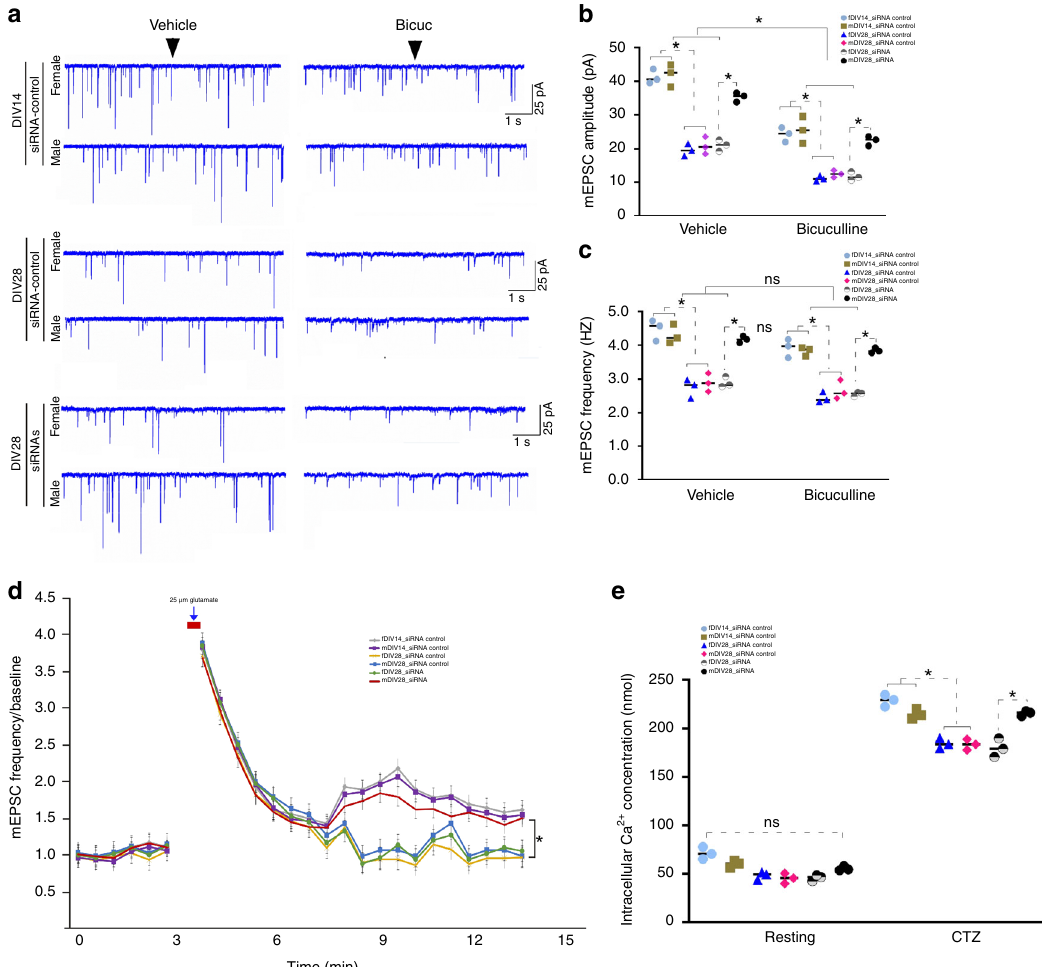
Fig. 7 CircGRIA1 regulates synaptic plasticity and calcium homeostasis. a Representative of mEPSC from hippocampal neurons. For bicuculline treatment, the neurons were incubated with bicuculline for 48 h followed by recording. Notes: fDIV14 and mDIV14, fDIV28 and mDIV28, hippocampal cultures of female and male fetal macaques at DIV14 and DIV28, respectively. b , c The average mEPSC wave forms and quanti fi cation of mEPSC amplitudes and frequency. The histogram showing a signi fi cant decrease in mEPSC amplitudes and frequency at DIV28 (* p = 0.00236 for amplitude, and * p = 0.00237 for frequency). Knockdown of circGRIA1 caused a signi fi cant increase in mEPSC amplitudes and frequency at DIV28 (* p = 0.00362 for amplitude, and * p = 0.00437 for frequency). Bicuculline treatment led to a signi fi cant decrease in mEPSC amplitudes. ANOVA F 7 , 79 = 13.594 *p = 0.0002, Tukey ’ s multiple comparisons DIV14 control vs. bicuculline, *p = 0.026; siRNA-control DIV28 control vs. bicuculline, *p = 0.023; siRNA DIV28 control vs. bicuculline, *p = 0.026 (n.s. no signi fi cance, n = 6 – 8 recordings of each culture from 2 to 3 fetal macaques per sex group). d Involvement of circGRIA1 in essential properties of cLTP. Data are presented as mean ± S.E.M.; *p < 0.05 vs. basal (ANOVA, Tukey post hoc test, n = 8 – 10 neurons of each culture from 2 to 3 fetal macaques per sex group). e CircGRIA1 regulates calcium fl ux. Relative ratios of fl uorescence at an emission frequency of 510 nm and excitation frequencies of 340 and 380 nm was collected and analyzed. Data are present as mean ± S.E.M. ( n = 8 – 10 cells of each culture from 2 to 3 fetal